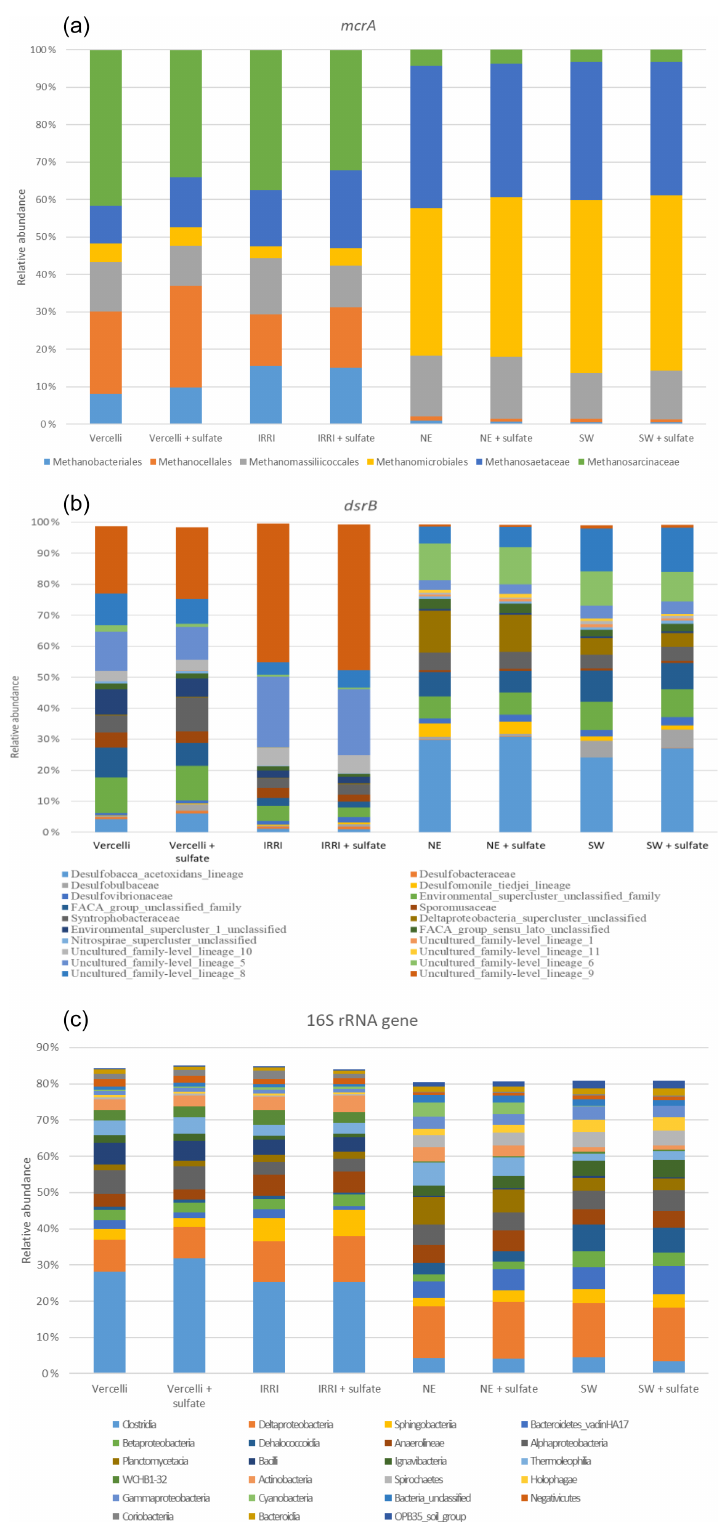
Figure 7. Relative abundance of (a) mcrA (methanogens), (b) dsrB (sulfate reducers) and (c) bacterial 16S rRNA genes. The DNA was ex- tracted after preincubation of phosphate-buffered suspensions of paddy soils (Vercelli and IRRI) and sediments of Lake Fuchskuhle (north- eastern and southwestern basins) without additions (methanogenic conditions) or preincubated and incubated in the presence of sulfate (sulfidogenic